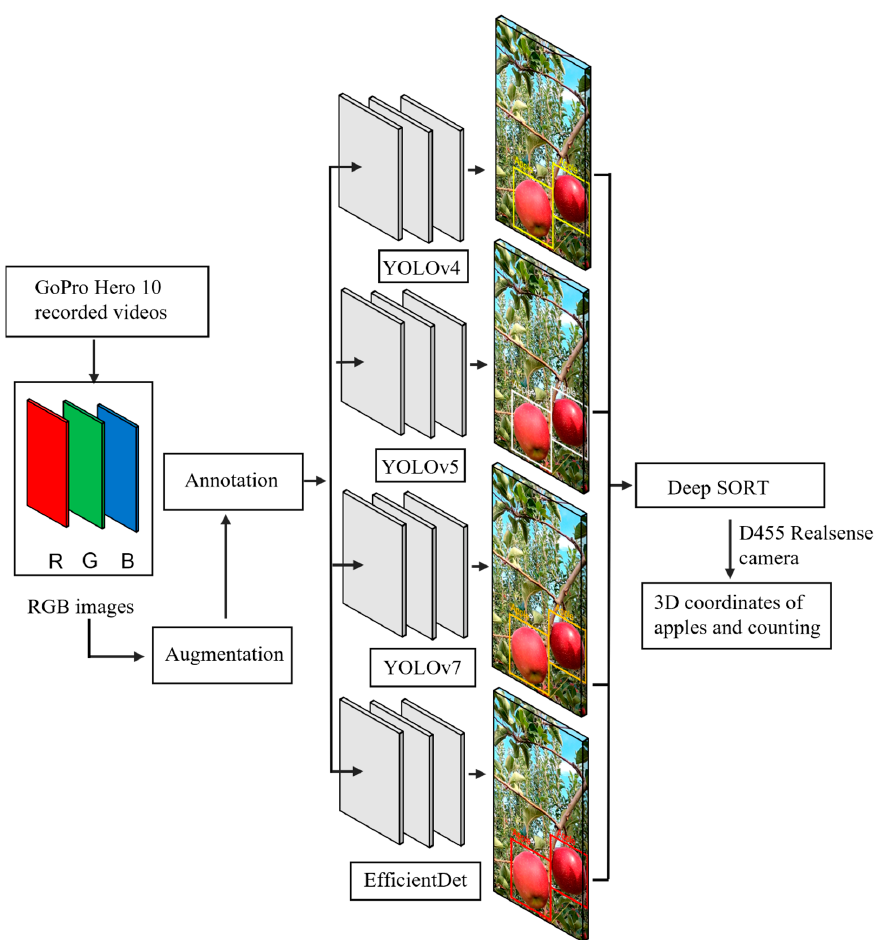
Figure 4. Data augmentation process and training nets for dataset preparation for training and counting using YOLOv4, YOLOv5, YOLOv7, EfficientDet, and Deep